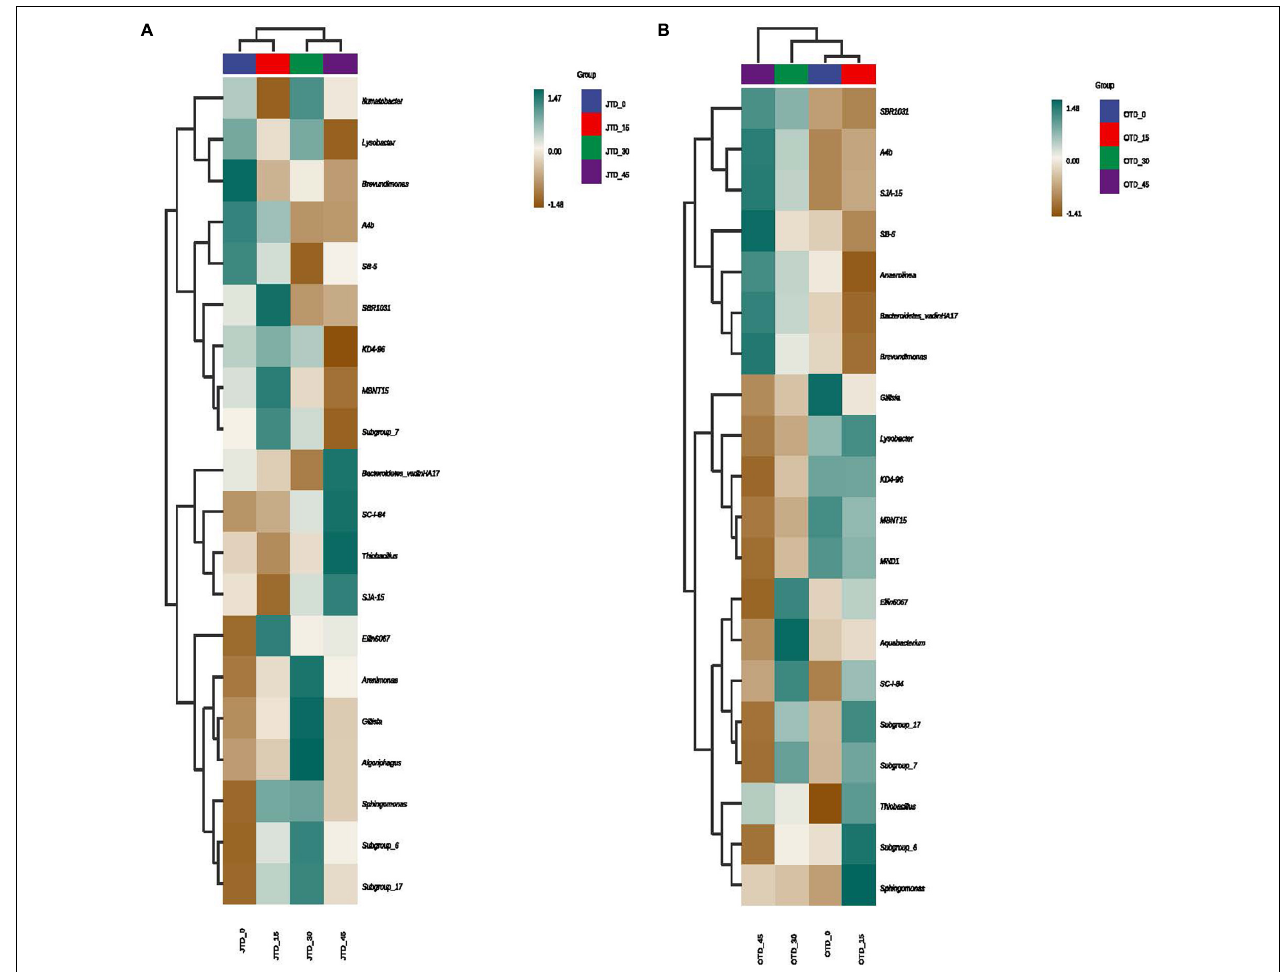
FIGURE 3 | Hierarchical clustering analysis of bacterial communities under different protein content diets treatments in July (A) and October (B) .